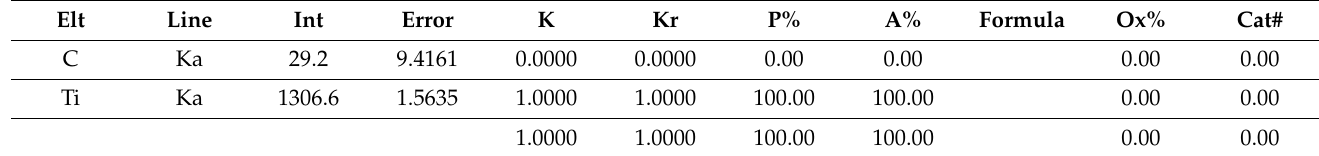
Figure 7. The spectroscopy of the Straumann implant’s neck.